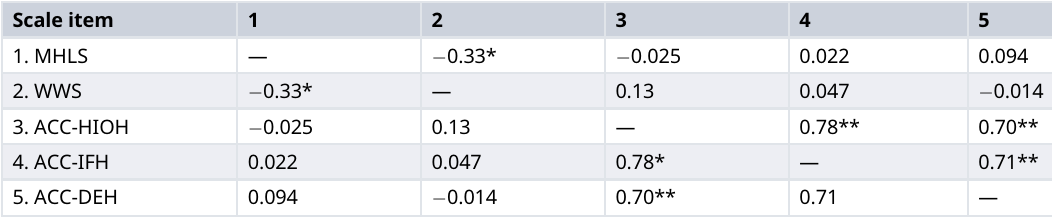
Table 5. Correlations between the MHLS, WWS, ACC-HIOH, ACC-IFH and ACC-DEH. Scale item